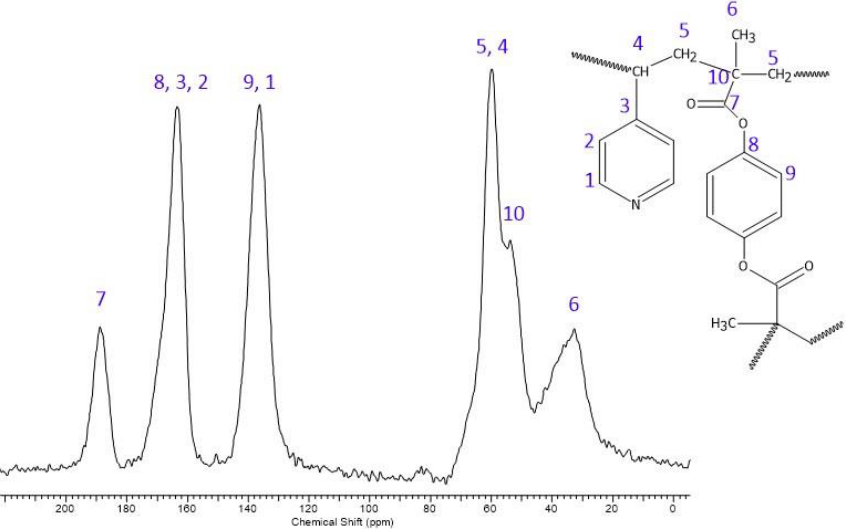
Figure 3. 13 C CP/MAS NMR spectrum of poly(4VP- co -14DMB).